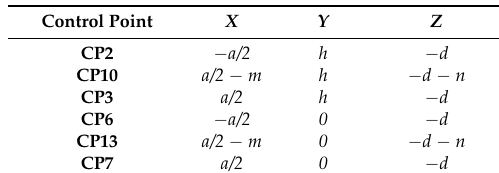
Figure 4. Coordinate system. Table 1. Spatial coordinates of CPs from geometrical rules. Only the central CPs are depicted as an